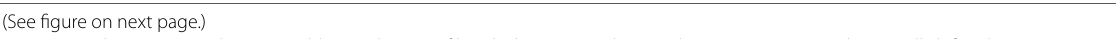
Fig. 2 Female patient aged 30 years old, complaining of headache. A , B Axial pre and post contrast T1WI show: well‑defined isointense extraxial dural based SOL in right frontal lobe with intense homogenous enhancement on CE‑T1WI. C , D Axial pre and post contrast FLAIR images show: the lesion appear isointense on precontrast FLAIR images with surrounding mild perifocal edema and showing peripheral rim of enhancement on CE‑FLAIR image. E CE‑FLAIR subtraction image show: more delineation of the lesion from the surrounding edema with more evident enhancement. F , G Pre and post contrast FLAIR at same level: measurements of the SI, denoting the difference between pre and post contrast and confirms the presence of enhancement (CEI 73, Lesion to background contrast ratio 0.55). H , I Pre and post contrast T1WI: measurements of the SI in pre and = = post contrast images (CEI 271, Lesion to background contrast ratio 0.81). Final = =